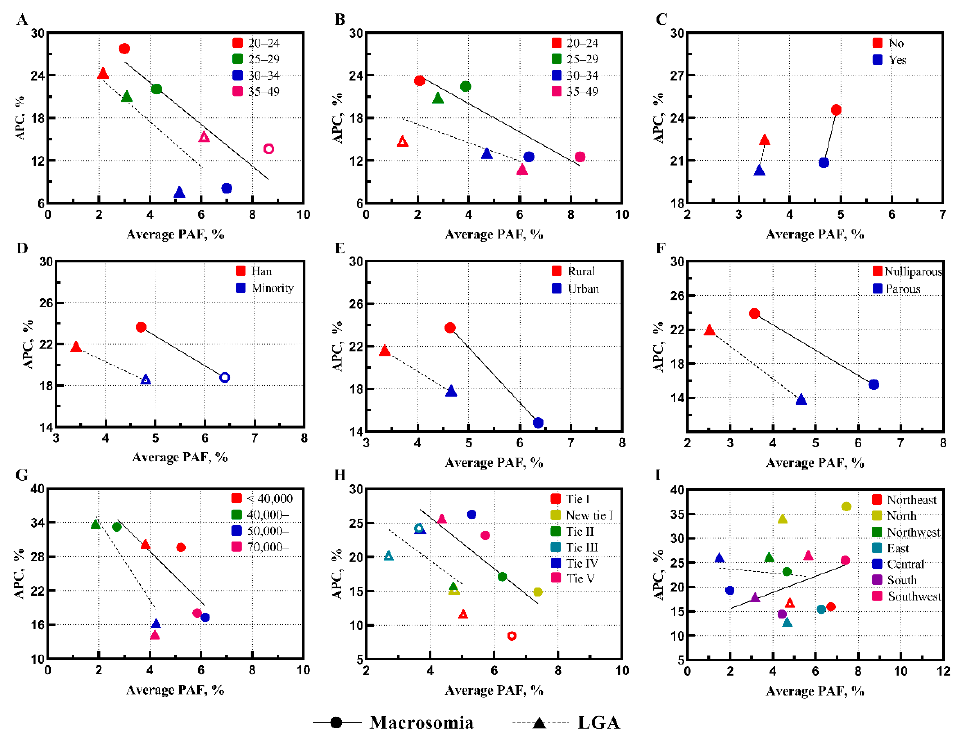
Figure 2. Within ‐ Population Heterogenicity of Burden and Trends of Macrosomic and LGA Figure 2. Within-Population Heterogenicity of Burden and Trends of Macrosomic and LGA Neonates Neonates Attributable to High Pre ‐ pregnancy Body Mass Index. Legend: (A) = maternal age; (B) = Attributable to High Pre-pregnancy Body Mass Index. Legend: ( A ) = maternal age; ( B ) = paternal age; paternal age; (C) = higher education; (D) = nationality; (E) = household registration; (F) = infant sex; ( C ) = higher education; ( D ) = nationality; ( E ) = household registration; ( F ) = parity; ( G ) = GDP per (G) = GDP per capita; (H) = city tier; and (I) = region. The straight and dashed lines are the linear capita; ( H ) = city tier; and ( I ) = region. The straight and dashed lines are the linear approximation of approximation of macrosomia and LGA, respectively. Hollow symbols represent annual percent macrosomia and LGA, respectively. Hollow symbols represent annual percent change of nonstatistical change of nonstatistical significance ( p > 0.05). significance ( p >